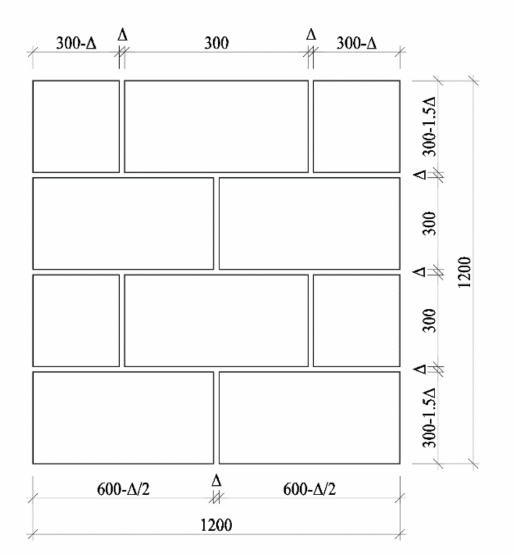
Figure 8. Composition of calculated masonry without plastering (unit: